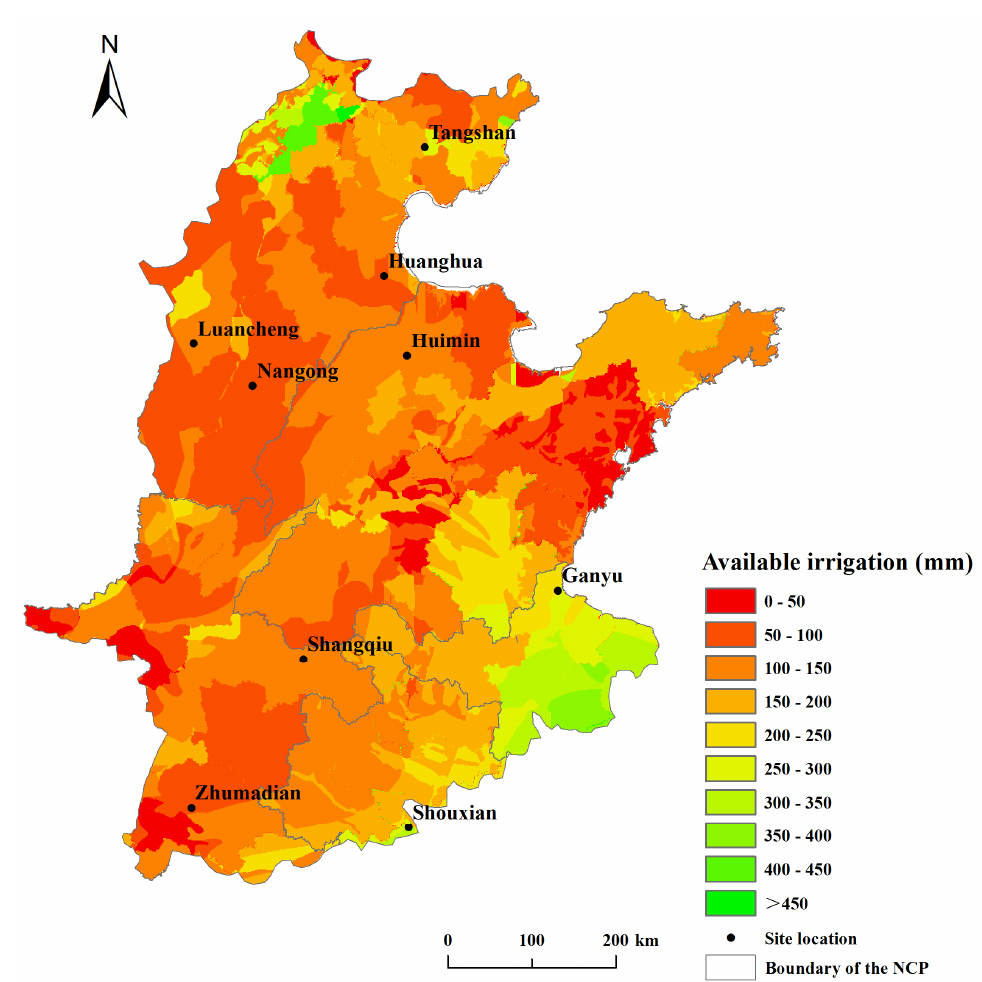
Figure 6. The irrigation availability of winter wheat in the North China